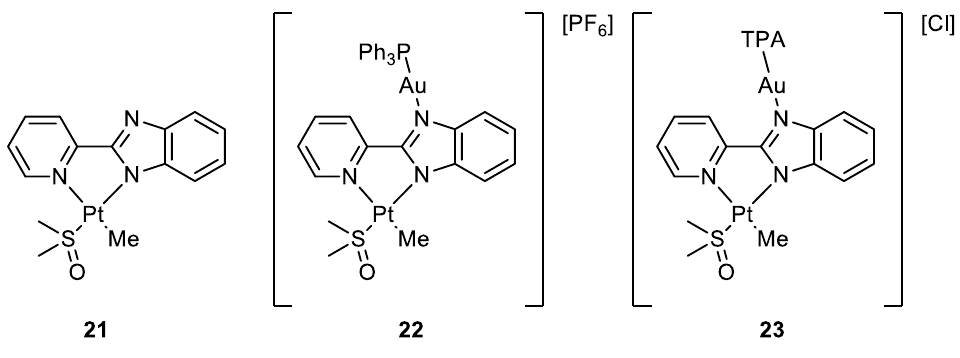
Figure 11. Molecular structure of compounds 21 – 23 .